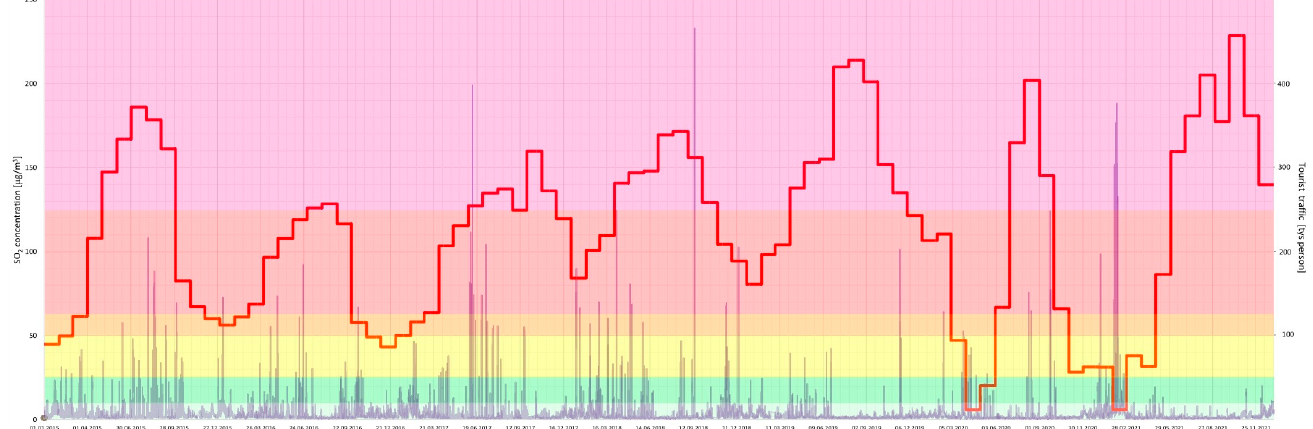
Figure 11. SO 2 concentration in relation to tourist traffic (the Gda ń sk agglomeration, years 2015–2021). Source: own study.